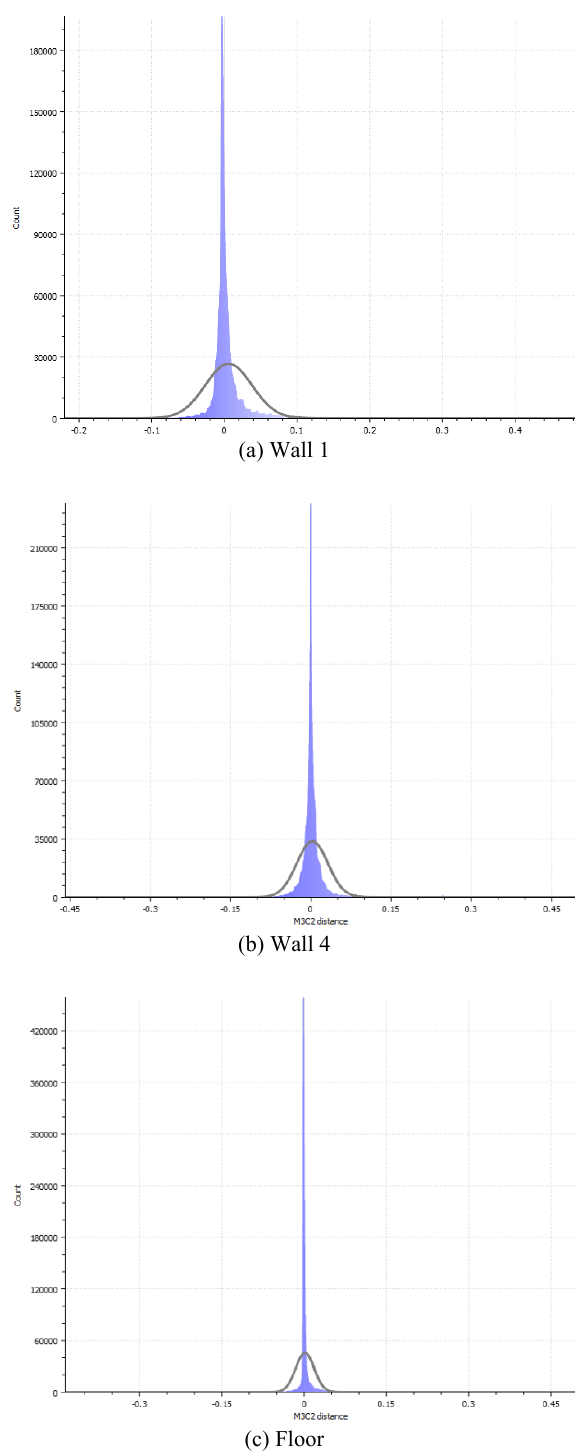
Figure 6. Distribution of differences in M3C2 distances (x is given in meters).